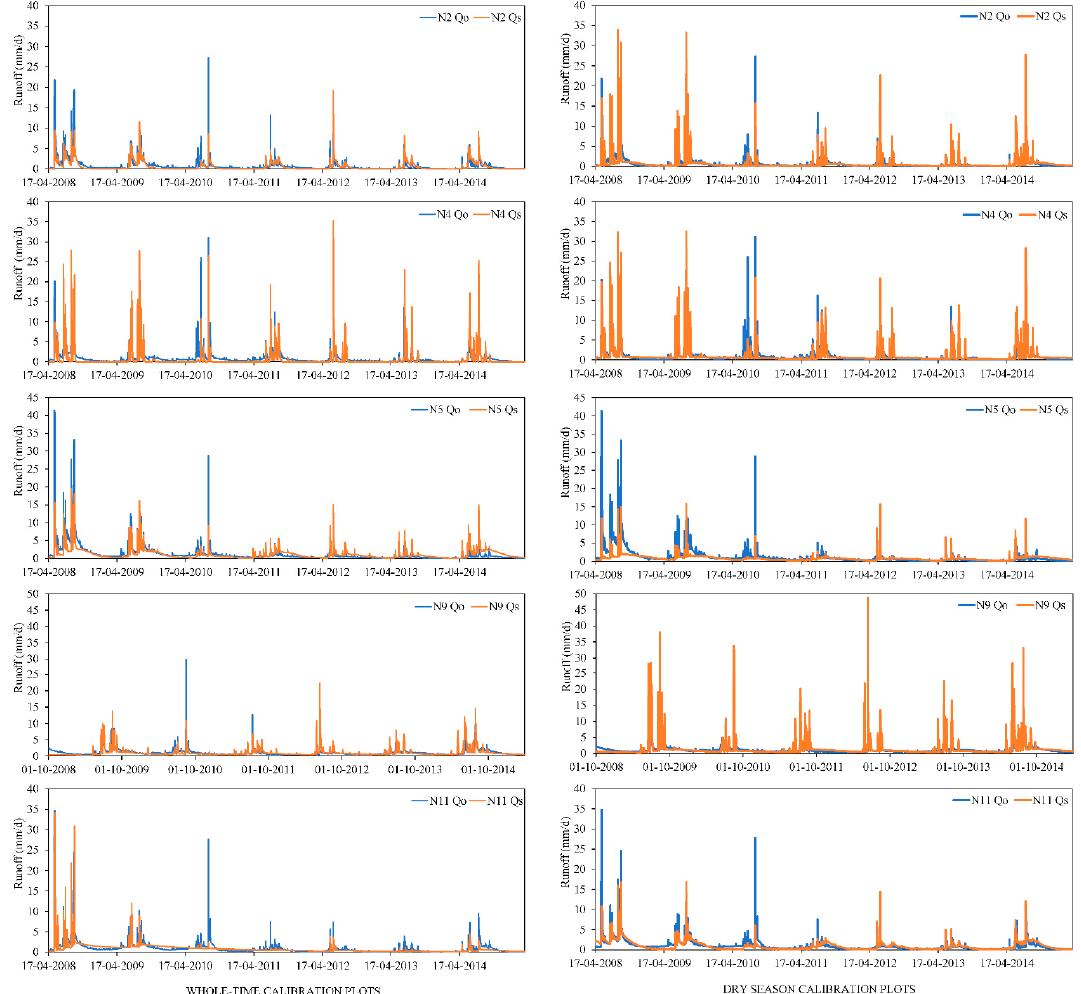
Figure 3. Simulated (Q s ) and observed (Q o ) runoff for the different catchments (i.e., additional supporting information on all catchments can be found online in the Supporting Information section at the end of the paper, Figure S2).